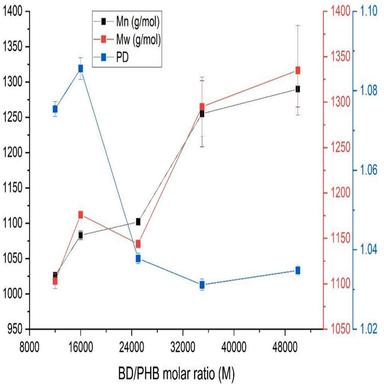
Effect of BD/PHB molar ratio on the Mn, Mw, and PD of PHB-diol products. Results are presented as the mean values of two independent replicates. The error bars represent the standard deviations of the mean values.